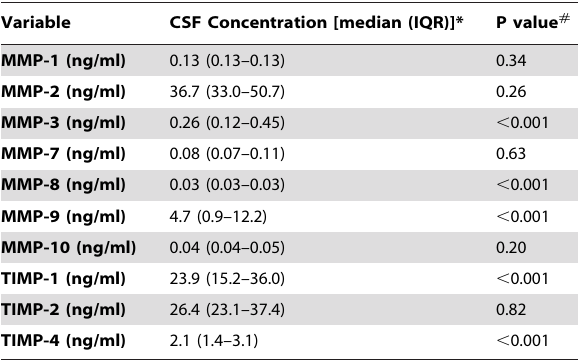
Table 3. Day 270 CSF MMP/TIMP concentrations (n=19).